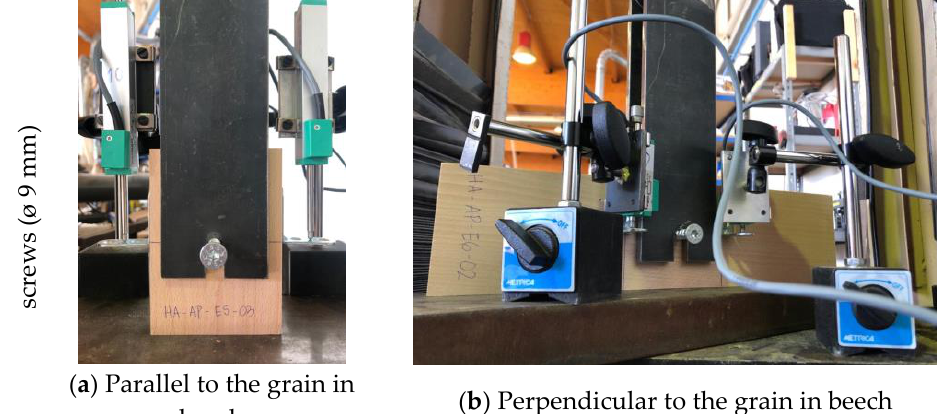
Figure 1. Scheme of experimental tests.